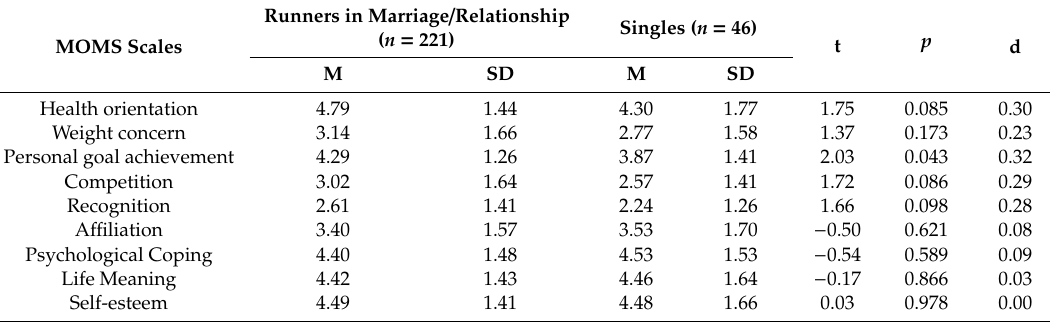
Table 2. Runners in marriage / relationship vs. singles.